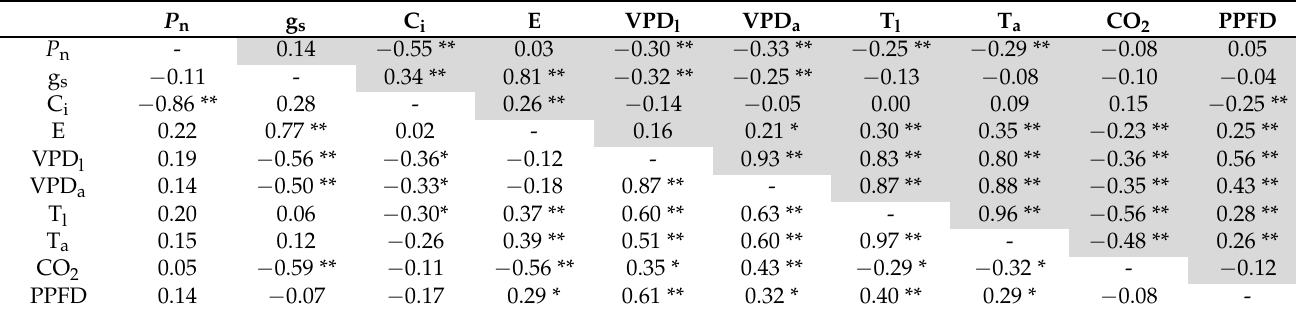
Table 2. Correlation coefficients for Zelkova serrata (Thunb.) Makino between gas exchange parameters (P n : net photosyn- thetic rate, g s : stomata conductance, C i : intercellular CO 2 concentration, E: transpiration rate) and environmental factors (VPD l : leaf to air vapor pressure deficit, VPD a : vapor pressure deficit, T l : leaf temperature, T a : air temperature, CO 2 : ambient CO2 concentration, PPFD: photosynthesis photon flux density) in dry (gray) and wet (white)